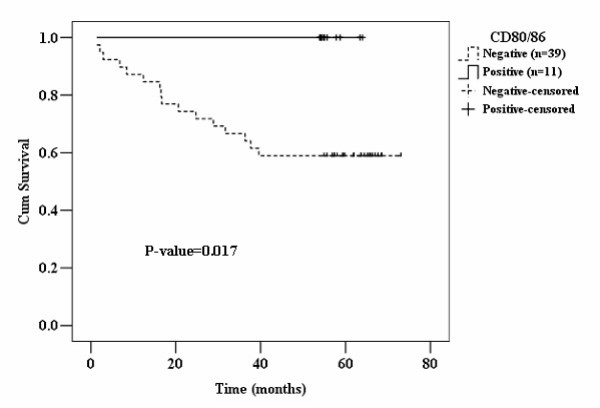
Kaplan-Meier survival curves based on expression of CD80/CD86 for patients with nasopharyngeal carcinoma.